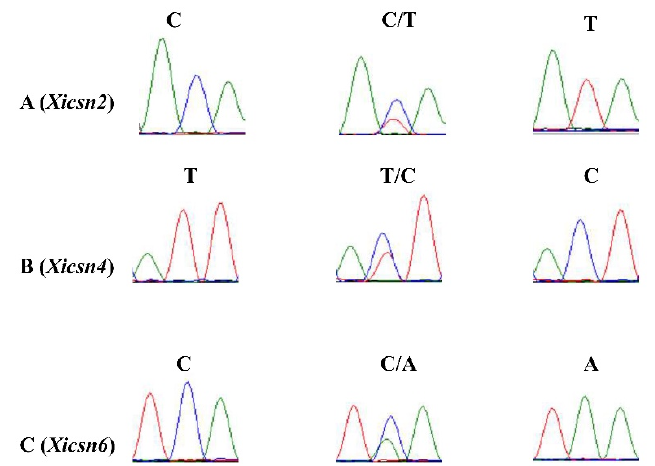
Figure 3. Sanger sequencing profiles of SNP markers Xicsn2 ( A ), Xicsn4 ( B ) and Xicsn6 ( C ) in the homozygously resistant (R), homozygously susceptible (S), and heterozygous F 2:3 lines (H) from the mapping population of the Xuxusanyuehuang × Zhongzuo 9504 cross. Blue, green, and red lines represent bases of cytosine (C), adenine (A), and thymine (T), respectively.